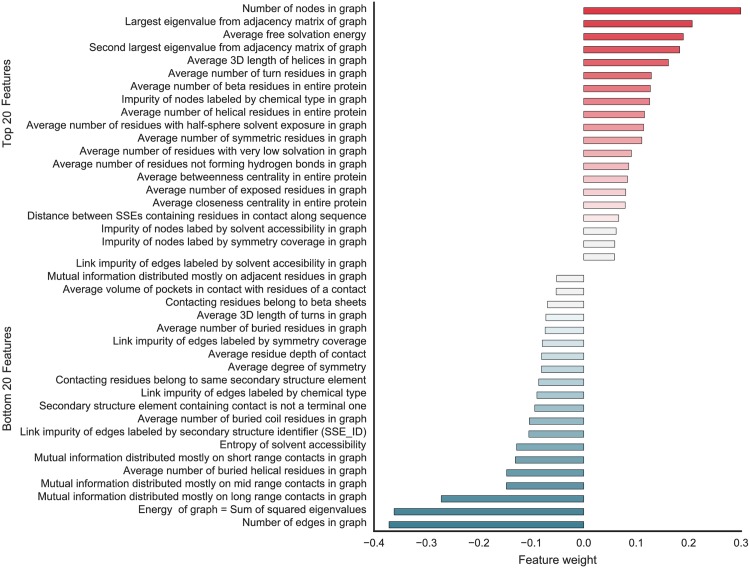
Top20 and Bottom20 features ranked by weight of the linearSVM.Features with largest weight are most important to classify breaking contacts, while features with minimum negative weight serve to identify maintained contacts. The graph refers to the neighborhood graph defining the local context of a single contact (see Methods). Features characterizing the different properties of this graph seem to dominate the classification.